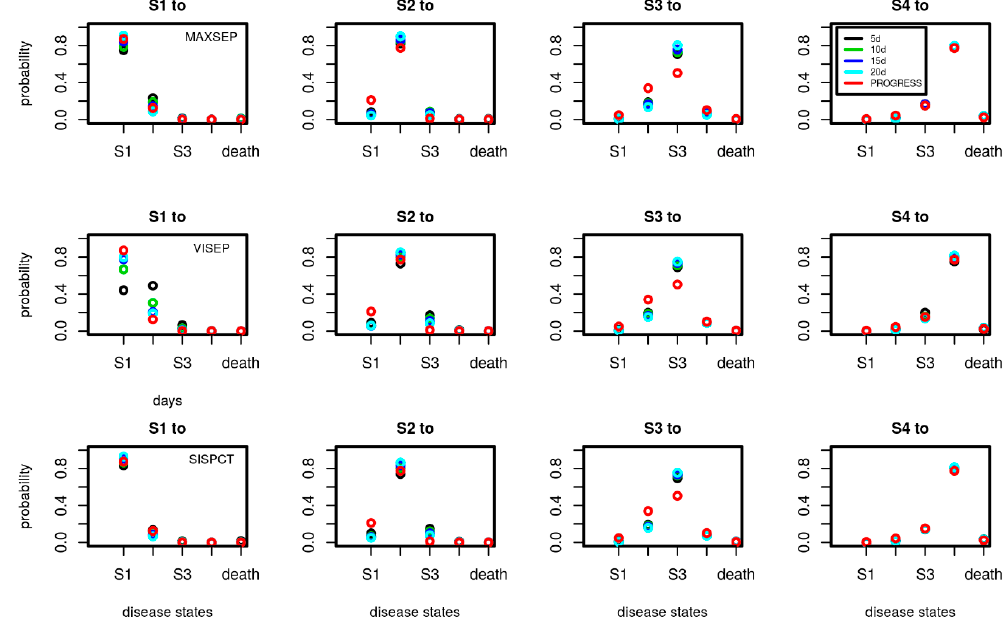
Figure A1. Comparison of transition probabilities between disease states estimated for the SepNet trials in dependence on the number of data points used for calibration (5, 10, 15, and 20 days). Each subfigure shows the daily transition probabilities from one disease state (title of figure) to the other possible disease states shown on the x-axis. Transition probabilities corresponding to calibration on 15 days are also shown in Figure 5 of the main document. We added the transition probabilities of PROGRESS for comparison. Good agreements of transition probabilities between studies and calibration scenarios were observed. An exception is VISEP showing stronger dependence of estimates on the number of time points used for calibration.